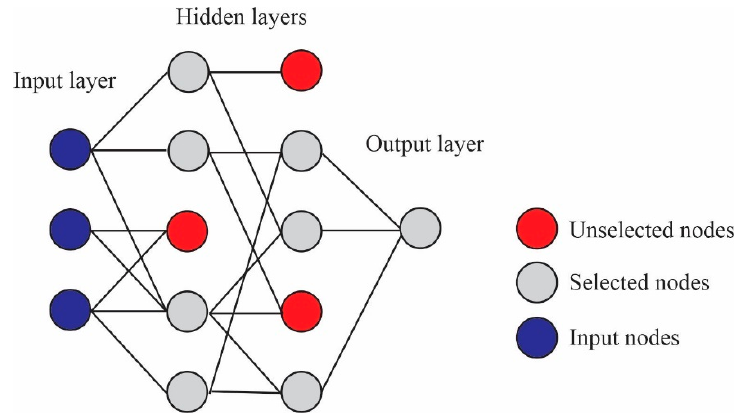
Figure 5. The architecture of a GMDH network.